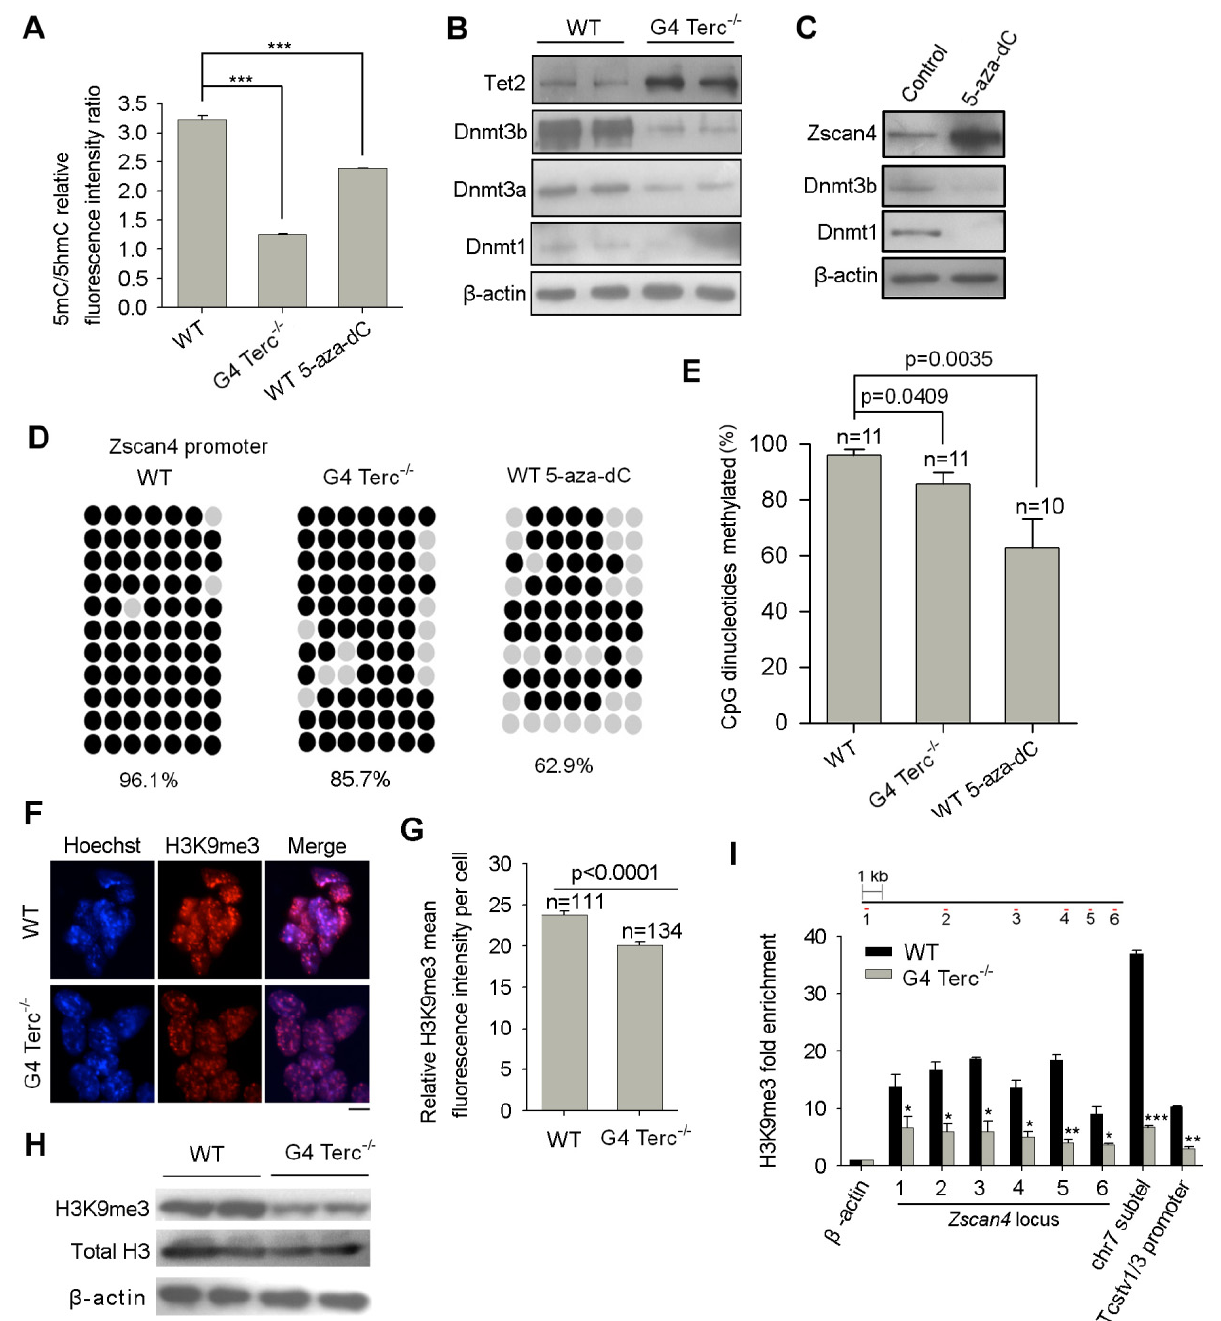
Figure 3. Reduction of DNA methylation and H3K9me3 occupancy at Zscan4 promoter regions in G4 Terc ‐ / ‐ ES cells with short telomeres. ( A ) Relative quantity (RQ) of DNA methylation levels among WT, G4 Terc ‐ / ‐ , and 5 ‐ aza ‐ dC treated WT ES cells (1 μ M for 2.5 days). Quantification was made by quantifying mean fluorescence intensity of cell populations following immunostaining with anti ‐ 5mC and 5hmC antibodies and analyzed by FlowJo software. Error bars indicate mean ± SEM ( n = 3). ***, p < 0.001, compared to WT controls. ( B ) Western blotting shows decreased Dnmt1, Dnmt3a, Dnmt3b, and increased Tet2 protein levels in G4 Terc ‐ / ‐ ES cells, respectively. Two technical repeats were included. ( C ) Western blotting shows decreased Dnmt1, Dnmt3b protein levels after 5 ‐ aza ‐ dC treatment (1 μ M for 2.5 days) in WT ES cells. ( D ) Bisulfate sequencing analysis of CpG dinucleotides of mouse Zscan4c proximal promoter regions among WT, G4 Terc ‐ / ‐ and 5 ‐ aza ‐ dC treated WT ES cells (1 μ M for 2.5 days). Open circles, unmethylated; closed circles, methylated. ( E ) Quantification of bisulfate genomic sequencing results of 10–11 independent clones (n) at Zscan4c proximal promoter. Note the decrease in methylated CpGs at Zscan4c proximal promoter in G4 Terc ‐ / ‐ and 5 ‐ aza ‐ dC treated WT ES cells compared with WT ES cells. Error bars indicate mean ± SEM. ( F ) Representative images shows immunofluorescence staining of heterochromatic H3K9me3 (red). Nuclei stained with Hoechst33342 (blue) show brighter fluorescence signal in the heterochro ‐ matin. Scale bar, 10 μ m. ( G ) Quantification of relative H3K9me3 mean fluorescence intensity